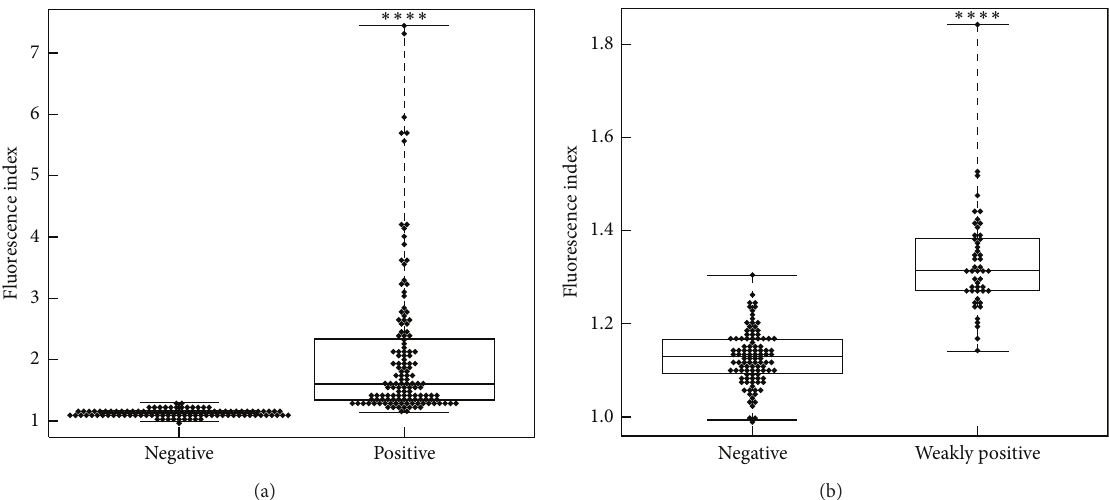
Figure 2: Fluorescence index in samples from the routine cohort ( 𝑛 = 237 ). (a) Comparison of samples with negative versus positive ANA in IIF. (b) Comparison of samples with negative versus weakly positive (titer = 100) ANA in IIF. Indexes were calculated with ICARE algorithm from captured IIF images and plotted for positive ANA patients (titer ≥ 100, 𝑛 = 134 ), weakly positive ANA patients (titer = 100, 𝑛 = 49 ), and negative ANA patients (titer < 100, 𝑛 = 103 ). The box plots show the median value and range from the first to the third quartile. The whiskers extend between the maximum and the minimum indices. Indexes from ANA positive patients as well as those from weakly positive patients were significantly higher than those from ANA negative patients ( 𝑃 < 0.0001 , Mann-Whitney 𝑈 test).